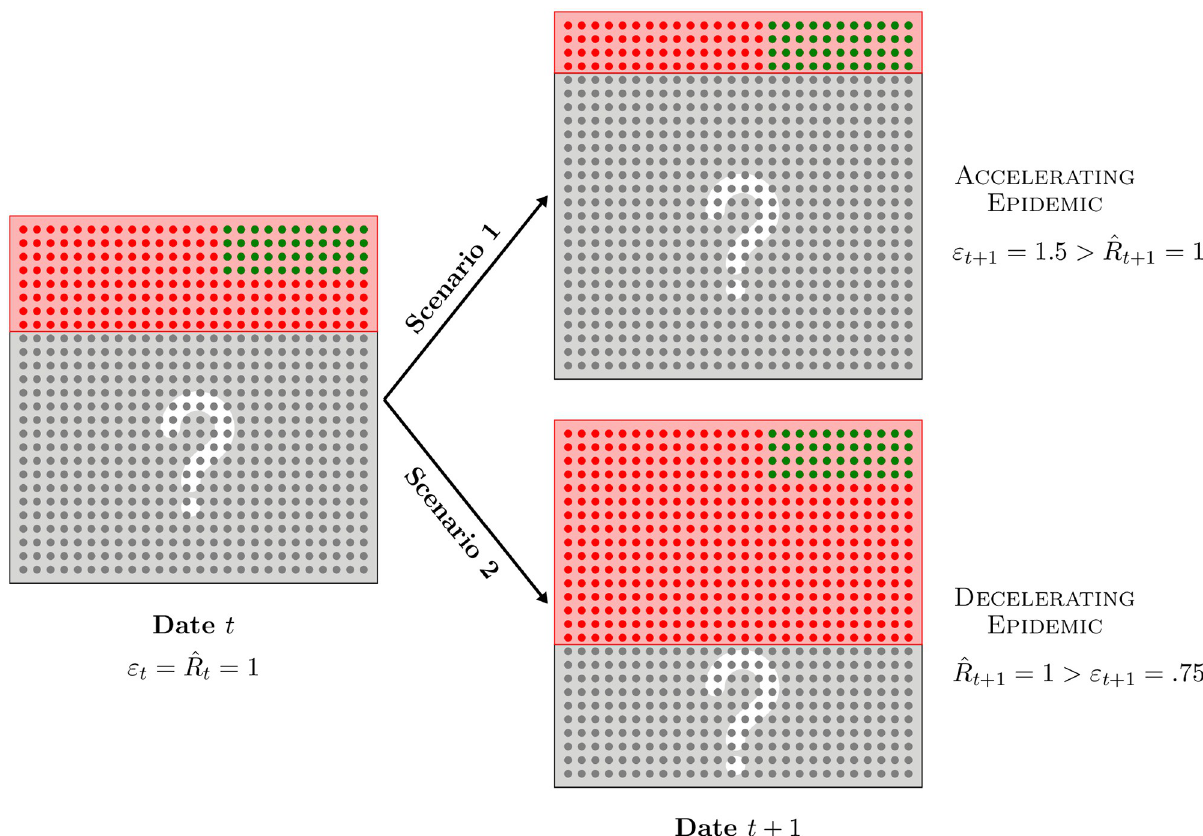
Fig 1. Schematic two-period example with both population and number of positive cases that stay constant over time. At each date, a dot represents one individual and red areas include individuals who have been tested, among which green (respectively red) dots represent positive (respectively negative) cases, while complementary grey areas depict untested individuals with unknown health status. From the situation at date t depicted in the left panel, two exclusive scenarii originate at t + 1 depending on whether the number of tests goes down (upper right) or up (bottom right), while the number of positive cases stay constant in each scenario, between t and t +